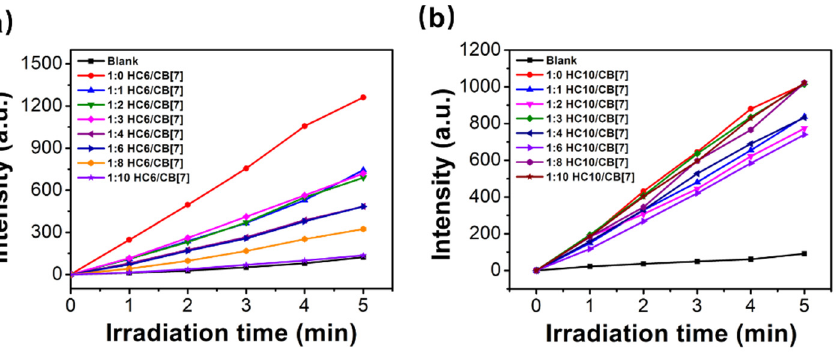
Figure 2. The ROS generation of ( a ) HC6 or ( b ) HC10 under the white light (5 mW/cm 2 ) after adding CB[7] in different proportions. DCFH is applied as the detection probe of ROS, and the excitation wavelength is 488 nm.